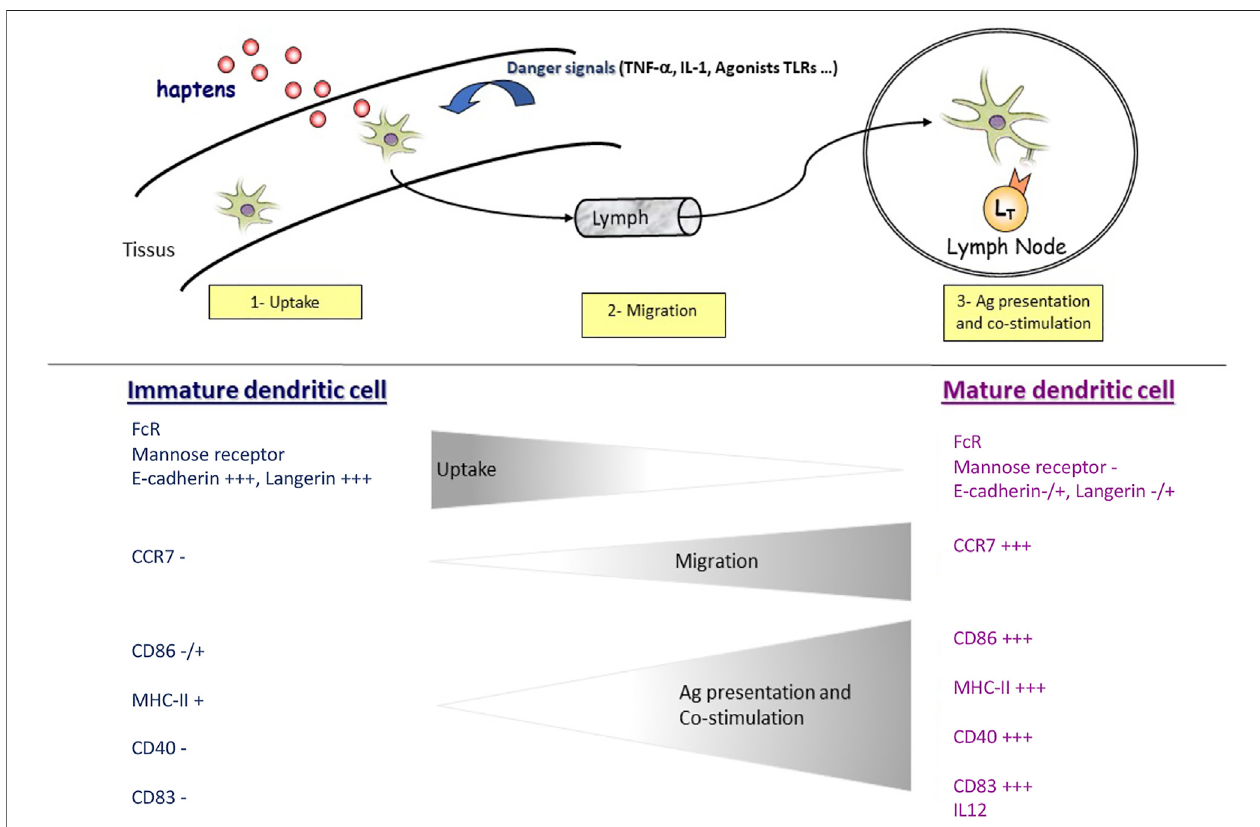
FIGURE 1 | In response to haptens and/or danger signals, immature DCs are activated into a mature phenotype. Immature DCs can capture and reprocess antigens. When DCs are activated, they lose this function and acquire the ability to migrate upon CCR7 expression. During this same activation, DCs also express speci fi c clusters of differentiation (CDs) involved in lymphocyte co-stimulation such as CD86 and interaction with T cells such as CD83. In addition, DCs can produce cytokines such as IL-12 and IL-23, participating in LT polarization.